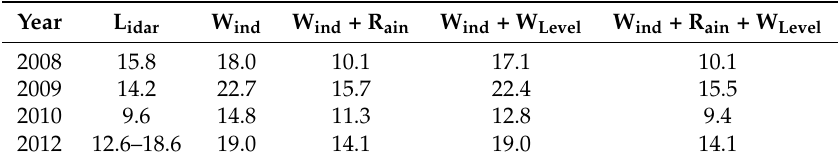
Table 8. Volume change during years in which maximum water level was lower than 2.0 m. The volumes correspond to those obtained from LiDAR data (based on considerations about measurement error) and to the calculated ones with Equation (6), considering hourly average wind speed data and a representative moisture content equal to 1%. The heading of each column represents the data considered to calculate the respective volume. Volumes in m 3 /m. Year L idar W ind W ind + R ain W ind + W Level W ind + R ain + W